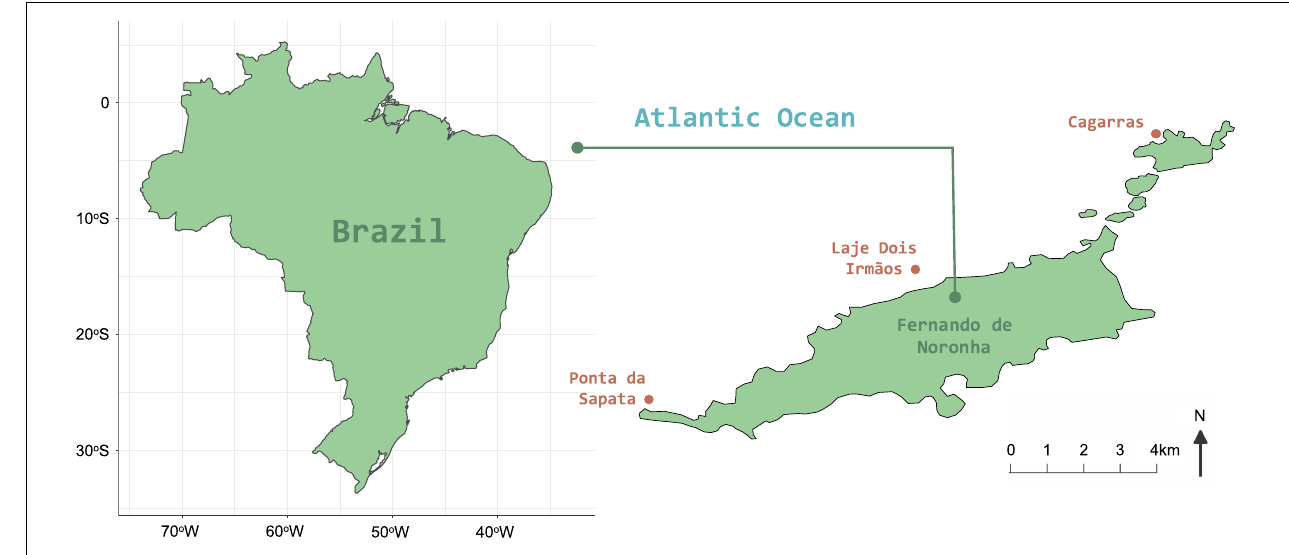
FIGURE 1 | Study area. Location of Fernando de Noronha Archipelago at 200 miles from Brazil’s northeast coast. The three sampling sites detailed in brown were annually sampled in October from 2013 to 2019 in order to assess temporal dynamics of the reef benthic